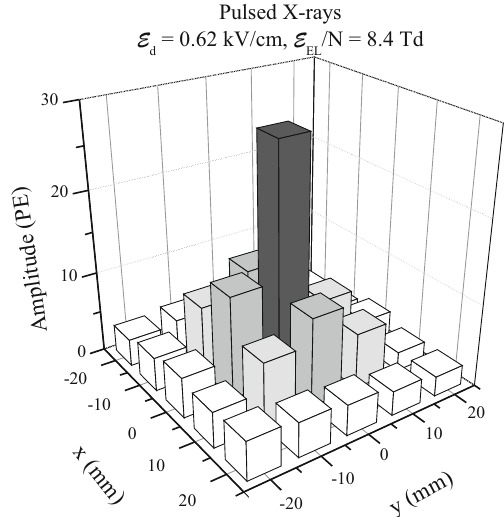
Fig. 16 Direct SiPM-matrix readout: the averaged distribution of pho- toelectrons over the SiPM-matrix channels in x,y plane for “central” events, in which the distribution’s maximum is at the central channel. The data were obtained at the maximum reduced EL field, of 8.4 Td, when the detector was irradiated by pulsed X-rays